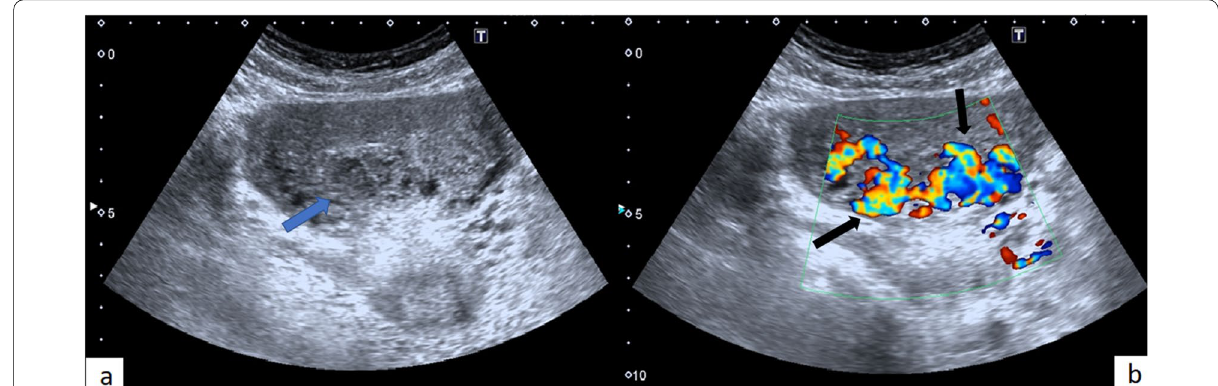
Fig. 1 Axial US ( a ) and CDUS ( b ) images. In the myometrium, there is a mass with multiple hypoechoic foci ( a , blue arrow). On a CDUS scan, increased vascularity can be noticed ( b , black arrows)